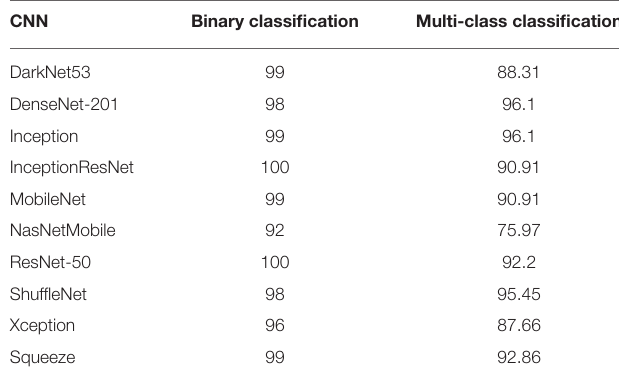
TABLE 2 | The classification accuracies (%) achieved using LSTM network trained with individual DL features for binary and multi-class classification